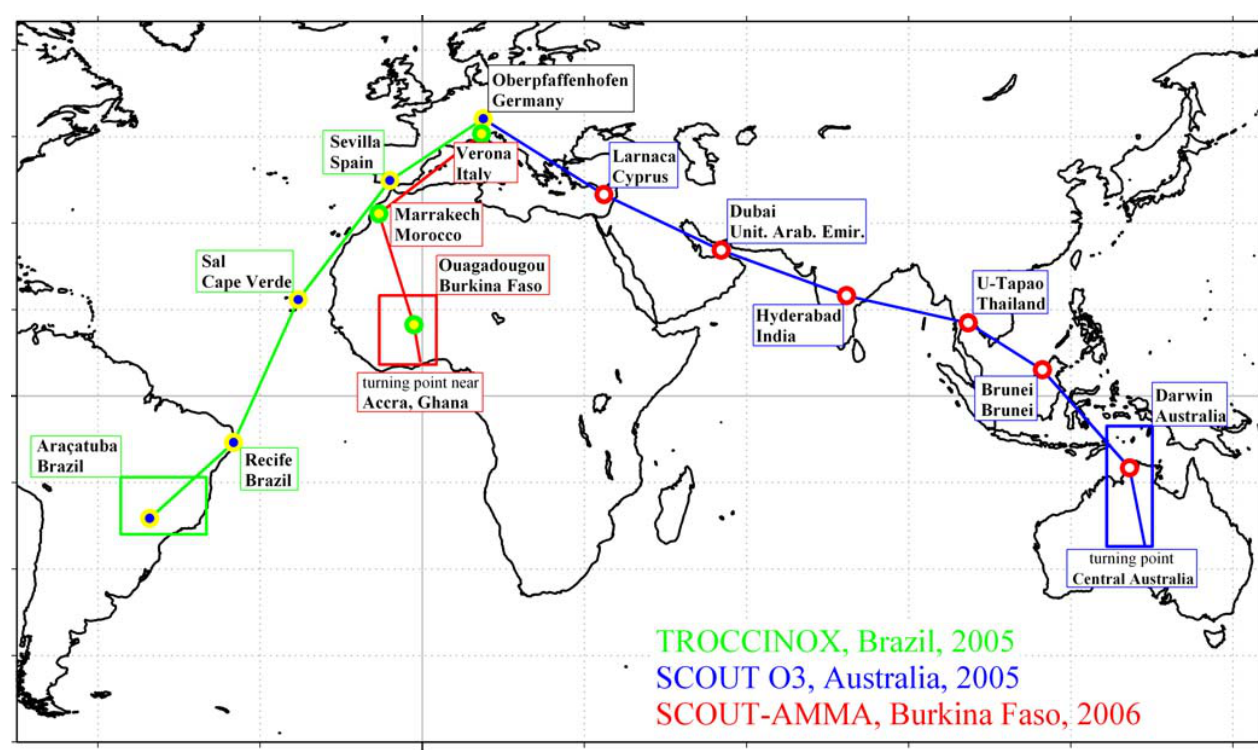
Fig. 1. Routes of the transfer flights for the M-55 “Geophysica” with intermediate landings between January 2005 and August 2006. The boxes indicate the areas where local research flights were carried out.